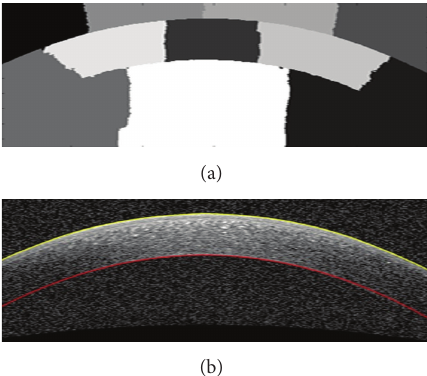
Figure 13: (a) The method to flattening the image using a horizontal line and Epithelium boundary. (b) Flat image.